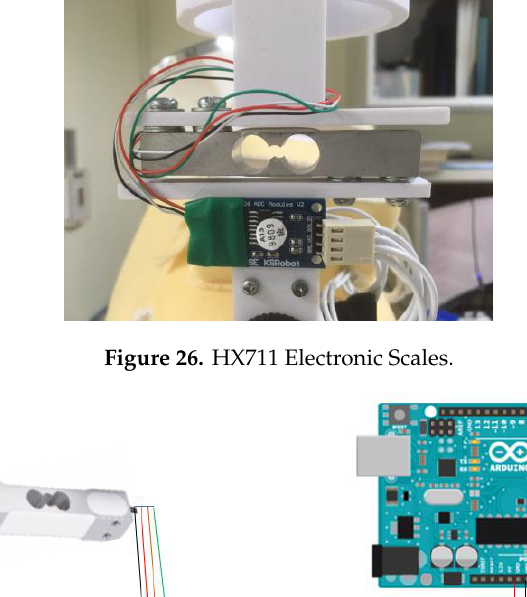
Figure 26. HX711 Electronic Scales.